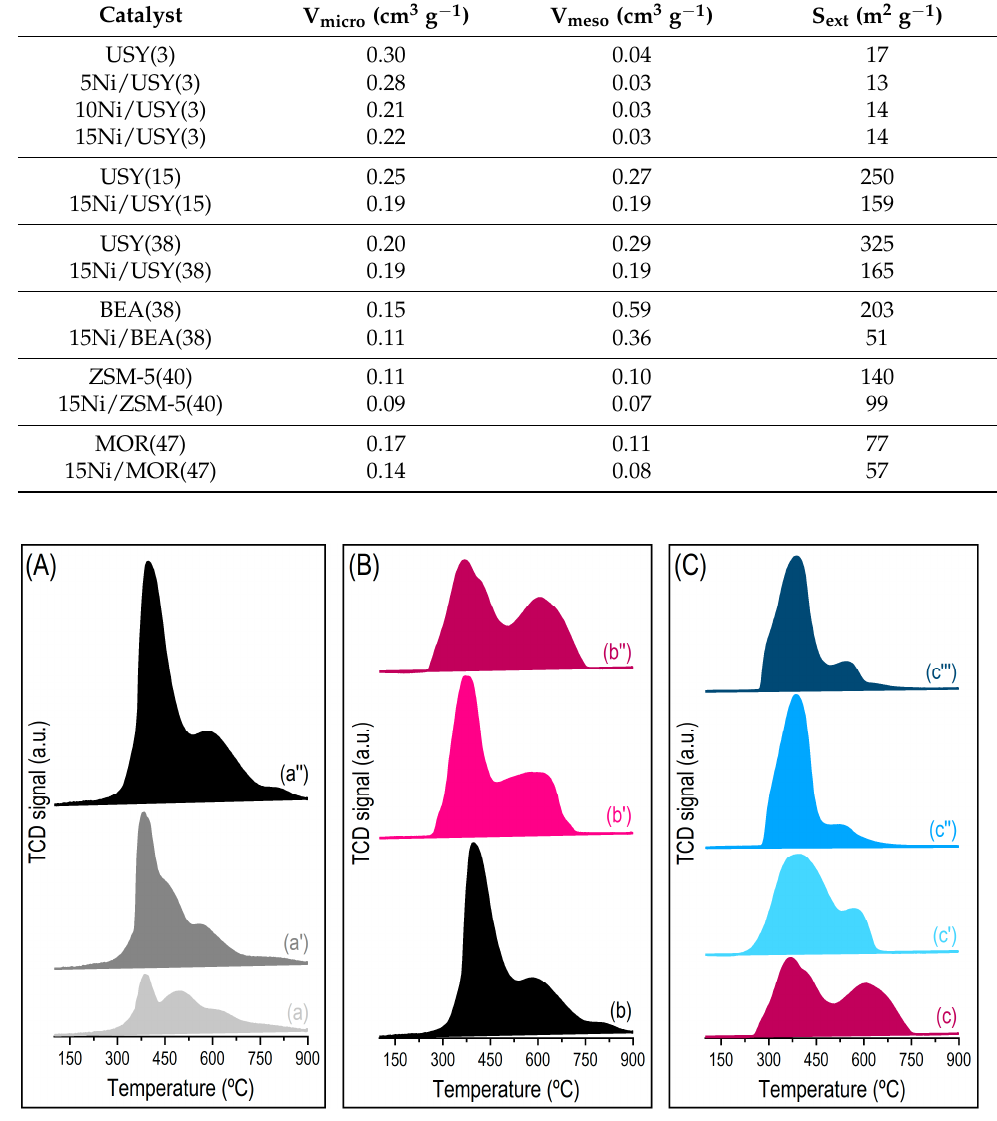
Figure 2. H 2 -TPR profiles of: ( A ) Ni loading samples: ( a ) 5Ni/USY(3), ( a ′ ) 10Ni/USY(3), and ( a ″ ) 15Ni/USY(3); ( B ) Si/Al ratio samples: ( b ) 15Ni/USY(3), ( b ′ ) 15Ni/USY(15), and ( b ″ ) 15Ni/USY(38); and ( C ) Framework type samples: ( c ) 15Ni/USY(38), ( c ′ ) 15Ni/BEA(38), ( c ″ ) 15Ni/ZSM5(40), and ( c ‴ ) 15Ni/MOR(47).